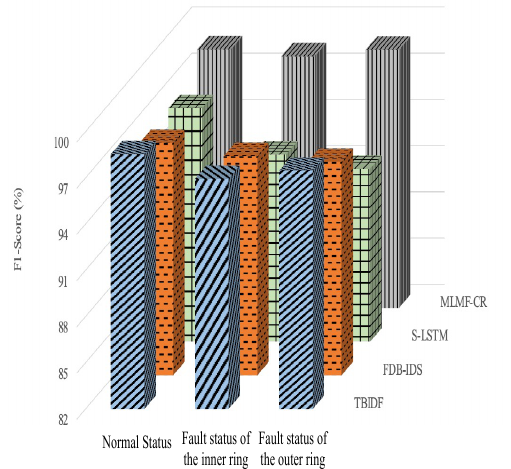
Fault status of Normal Status Fault status of the inner ring the outerring Figure 11. F1-Score indicators for different